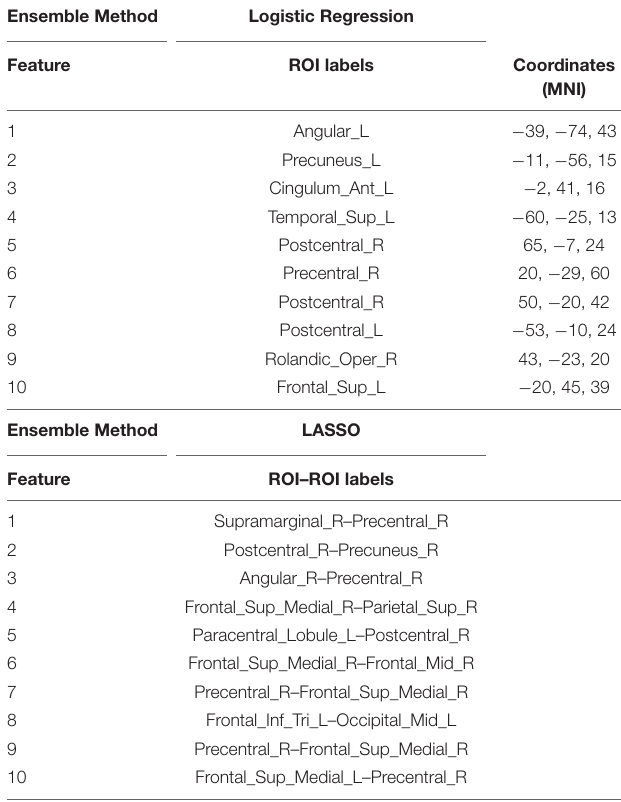
TABLE 2 | Dynamic functional connectivity and functional connectivity differences among NSR, SR, and HC groups. Region F p Pairwise comparison